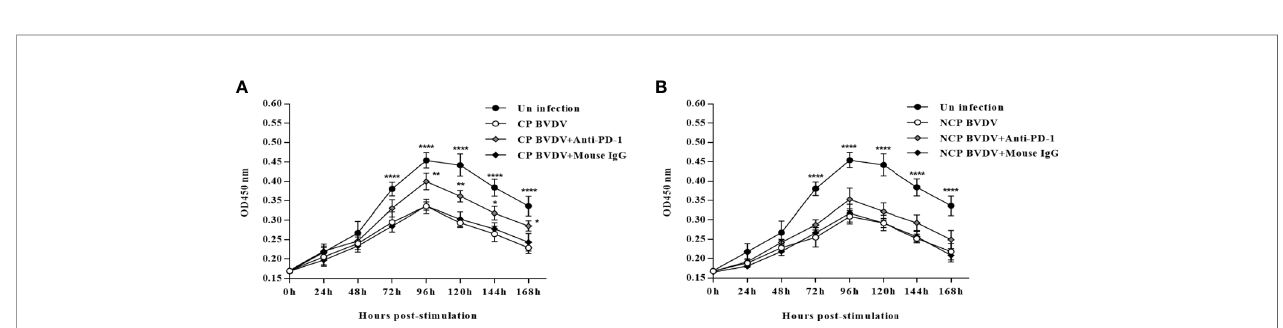
FIGURE 10 | Effect of PD-1 blockade on the proliferation of PBL from BVDV-infected mice from 0 h to 168 h post-infection. (A) Proliferation of PBL from CP BVDV- infected mice. (B) Proliferation of PBL from NCP BVDV-infected mice. **** p < 0.0001, ** p < 0.01, * p < 0.05. The animals were assigned into 7 experimental groups, including the mock-infected group, CP BVDV-infected group, CP BVDV+anti-PD-1 group, CP BVDV+mouse IgG group, NCP BVDV-infected group, NCP BVDV +anti-PD-1 group, and NCP BVDV+mouse IgG group. CP and NCP BVDV-infected mice were used as the controls. OD450 nm is proportional to the number of living cells and represents the level of PBL proliferation. Data are presented as mean ± SD (n = 10 per group) and analyzed using two-way